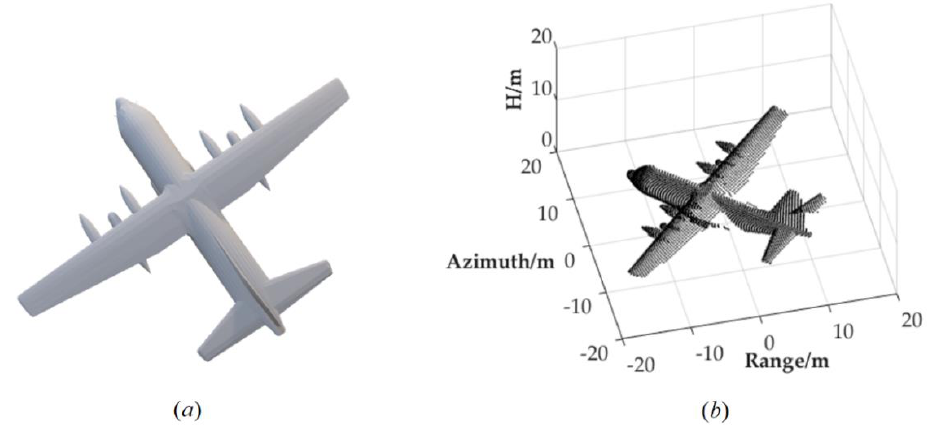
Figure 16. Airplane model and lattices: ( a ) airplane model; ( b ) airplane lattices.